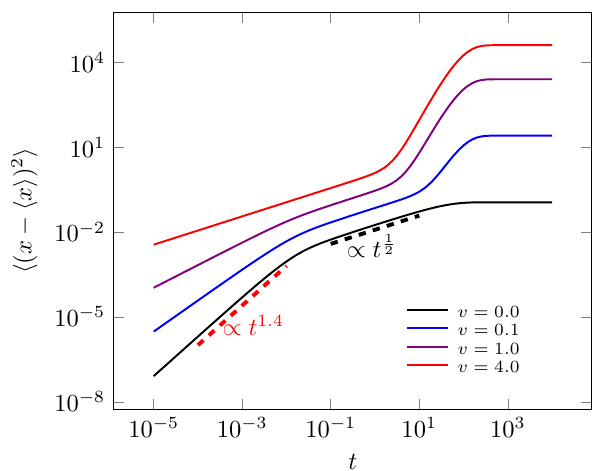
Figure 9. This figure represents time evolution of MSD behavior x axis (Equation (35)) to non-static stochastic resetting case, considering velocities to resetting